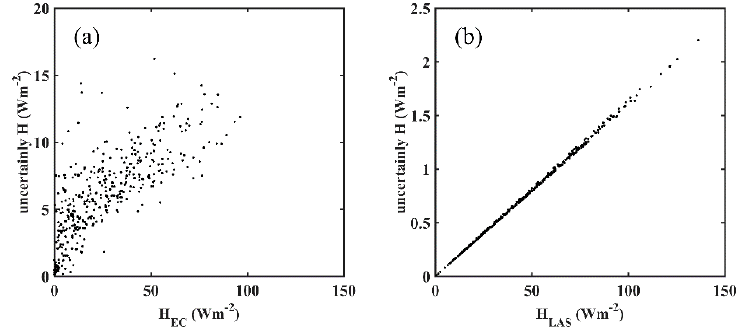
Figure 3. Uncertainty of ( a ) EC- and ( b ) LAS-derived sensible heat fluxes from measurements during this observation period.